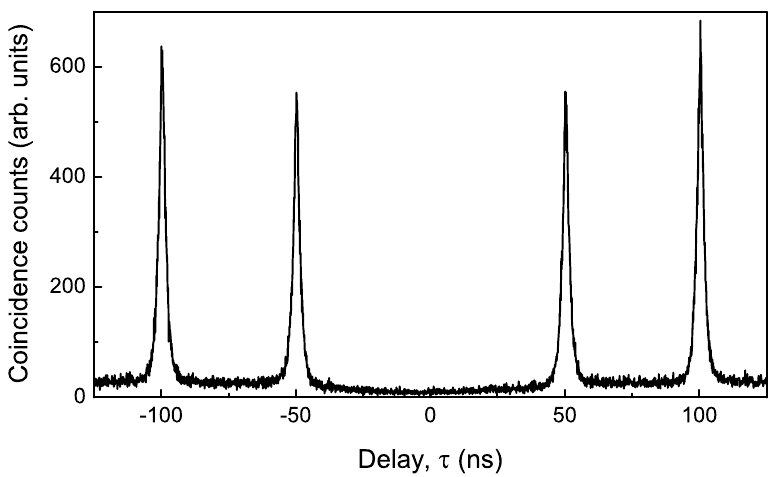
Figure 10. Coincidence counts of exciton photons emitted from a nanowire quantum dot embedded in an optimised photonic nanowire